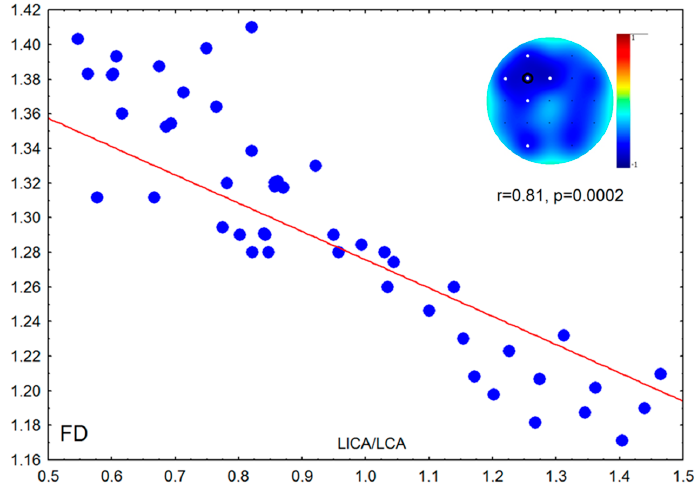
Figure 4. Scatterplot of fractal dimension (FD) against the ratio between the systolic peak velocities of the left internal and common carotid arteries (LICA/LCCA) in adults. White dots—significant correlations after Bonferroni correction and the permutation test; black circle—electrode used for